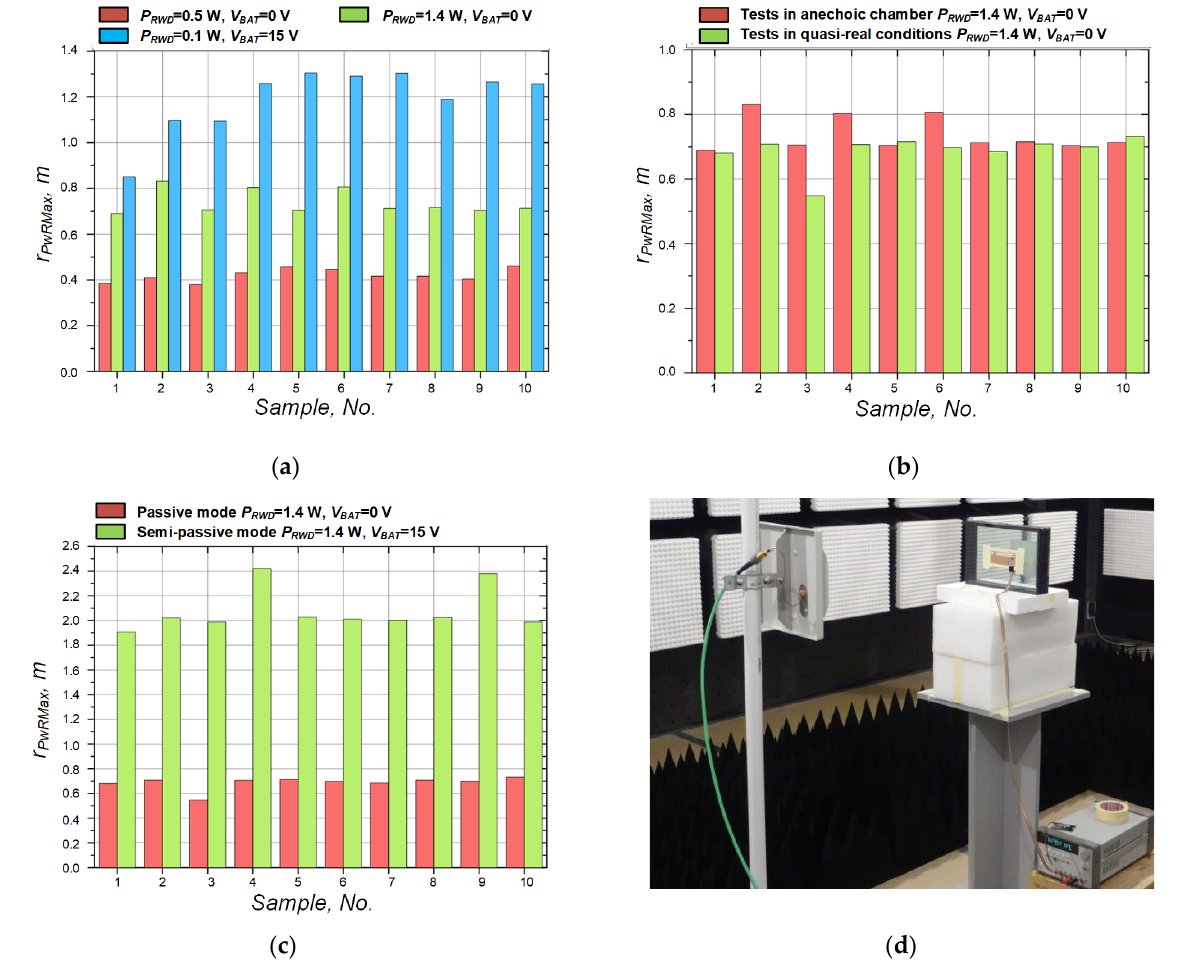
Figure 11. Read range r PwRMax of test samples: ( a ) determined for different values of output power of RWD P RWD and voltage on auxiliary power source V BAT ; ( b ) comparison of tests in anechoic chamber and in quasi-real conditions; ( c ) tests of passive and semi-passive mode in quasi-real conditions; ( d ) laboratory stand in anechoic chamber; inaccuracy of measurement method ± 1